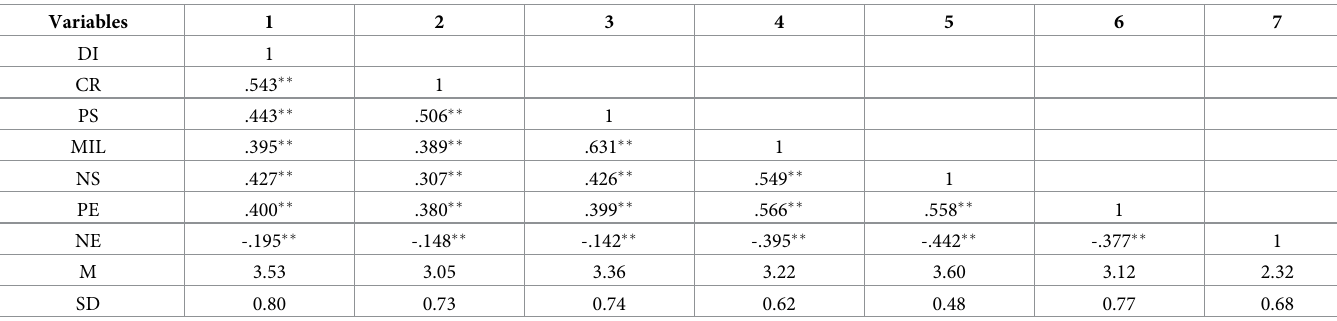
Table 1. Means, standard deviation, and bivariate correlation. Variables